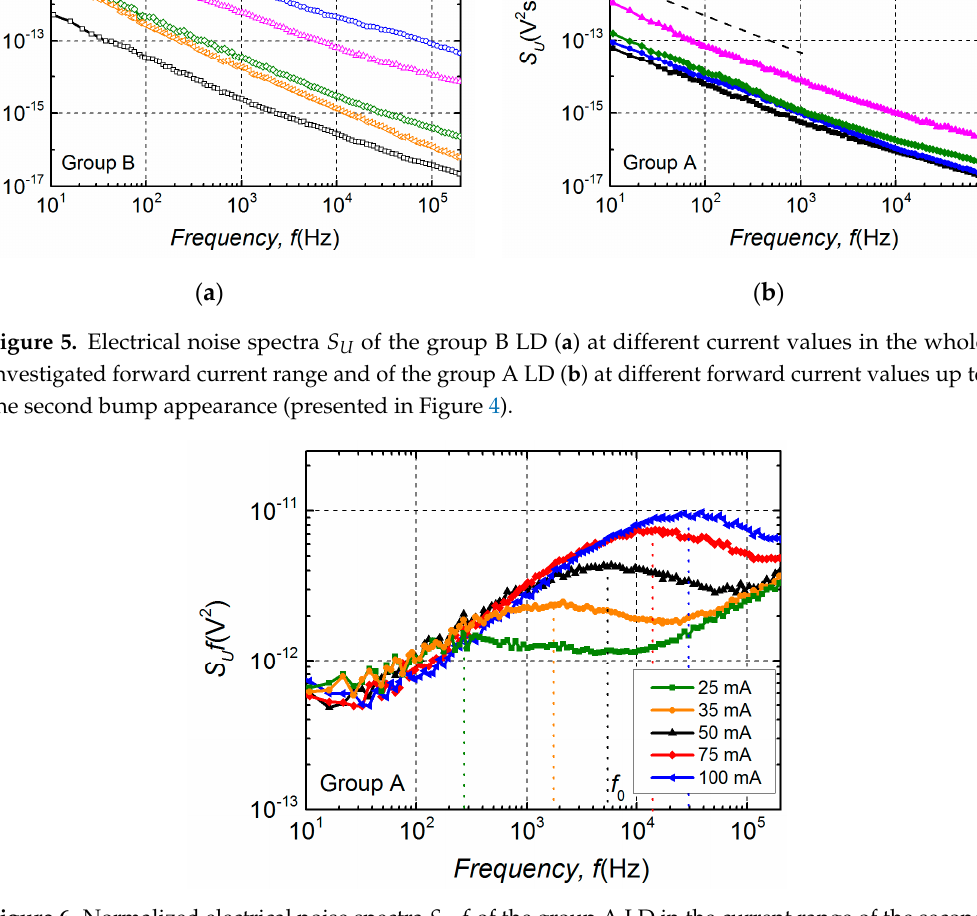
Figure 6. Normalized electrical noise spectra S U f of the group A LD in the current range of the second bump ( I > 15 mA in Figure 4).